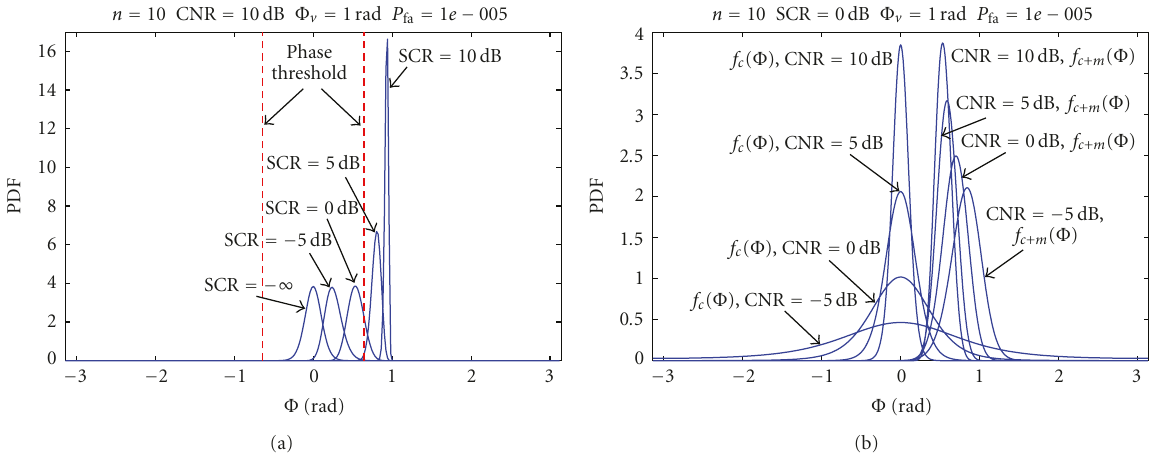
Figure 2: PDF of the interferometric phase of “clutter”and “clutter plus moving target” with Φ for n = 10, P fa = 1 e − 5, and Φ v = 1rad. (a) CNR = 10 dB, SCR = −∞ , − 5dB, 0dB, 5dB, 10 dB; (b) SCR = 0dB, CNR = − 5dB, 0dB, 5dB, 10 dB for f c ( Φ ) and f c + m ( Φ ).